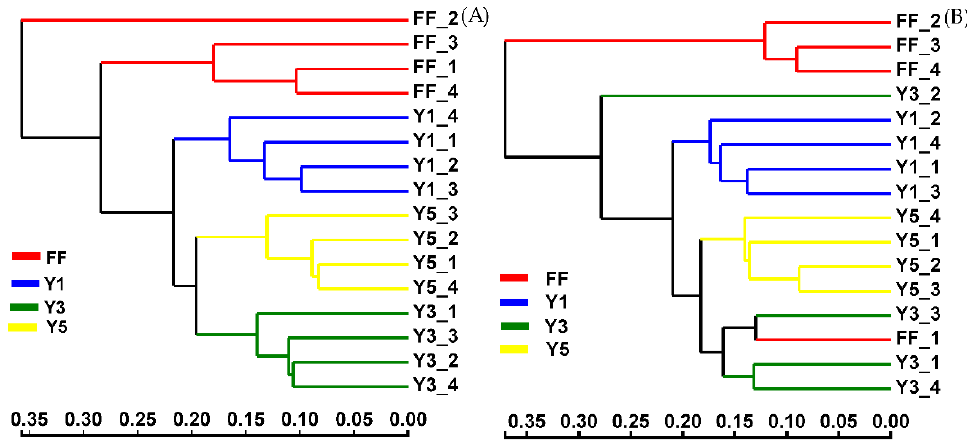
Figure 2. Bray–Curtis dissimilarity hierarchical cluster tree of soil fungal community; in winter ( A ) and summer ( B ); FF: fallow field soil; Y1: one ‐ year C. chinensis cultivated the soil; Y3: three ‐ year C.